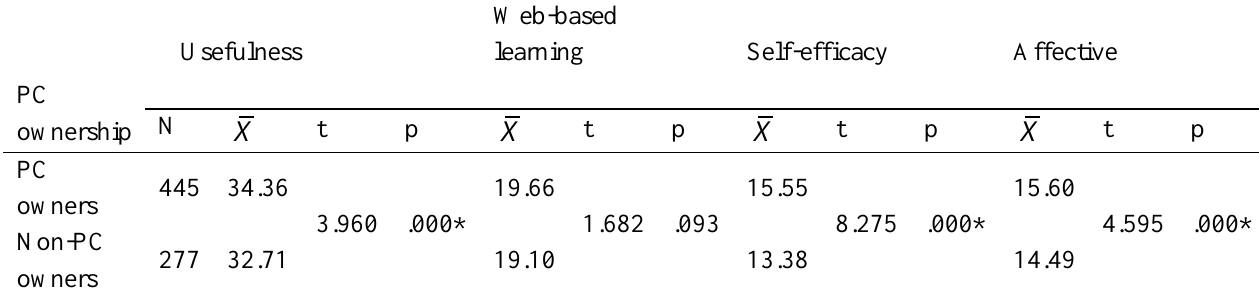
Differences in Perceptions toward the Web Based on PC Ownership